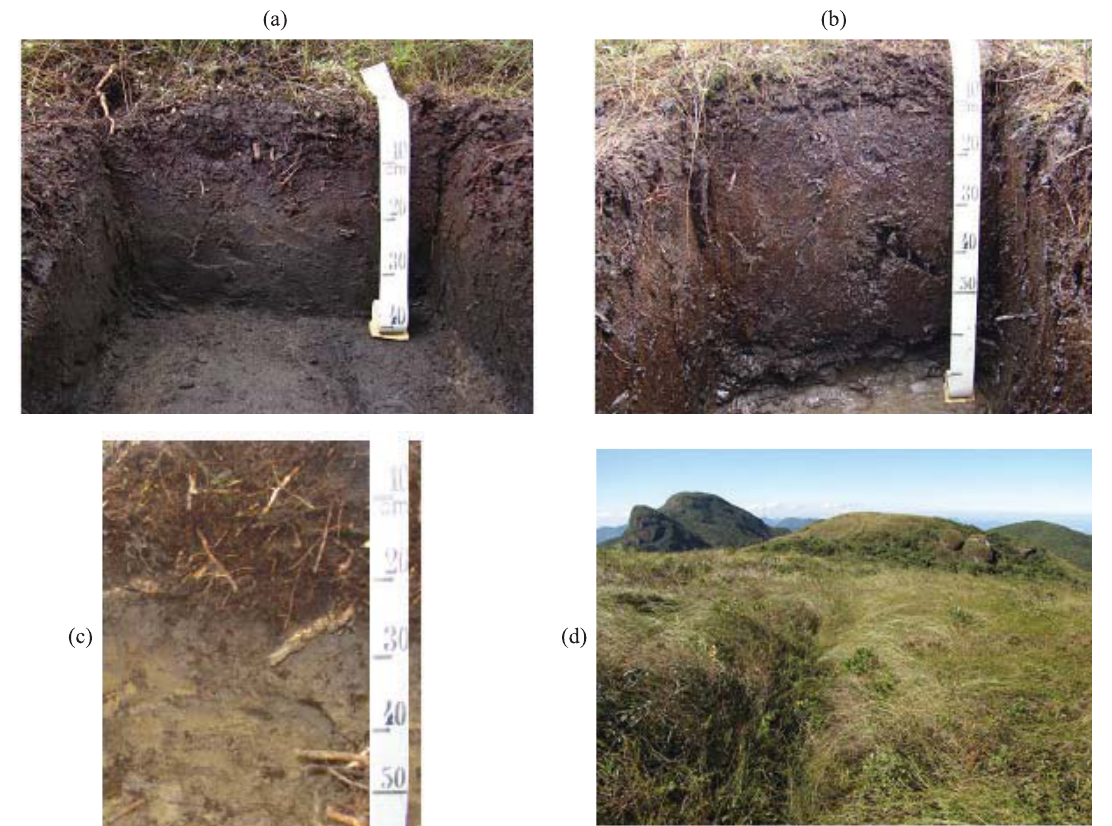
Figura 3. (a) perfil 1: Organossolo sob campo altomontano; (b) perfil 2: Organossolo sob campo altomontano com drenagem mais restrita; (c) perfil 3: Gleissolo sob floresta altomontana; e (d) trechos amostrados na Serra da Igreja,